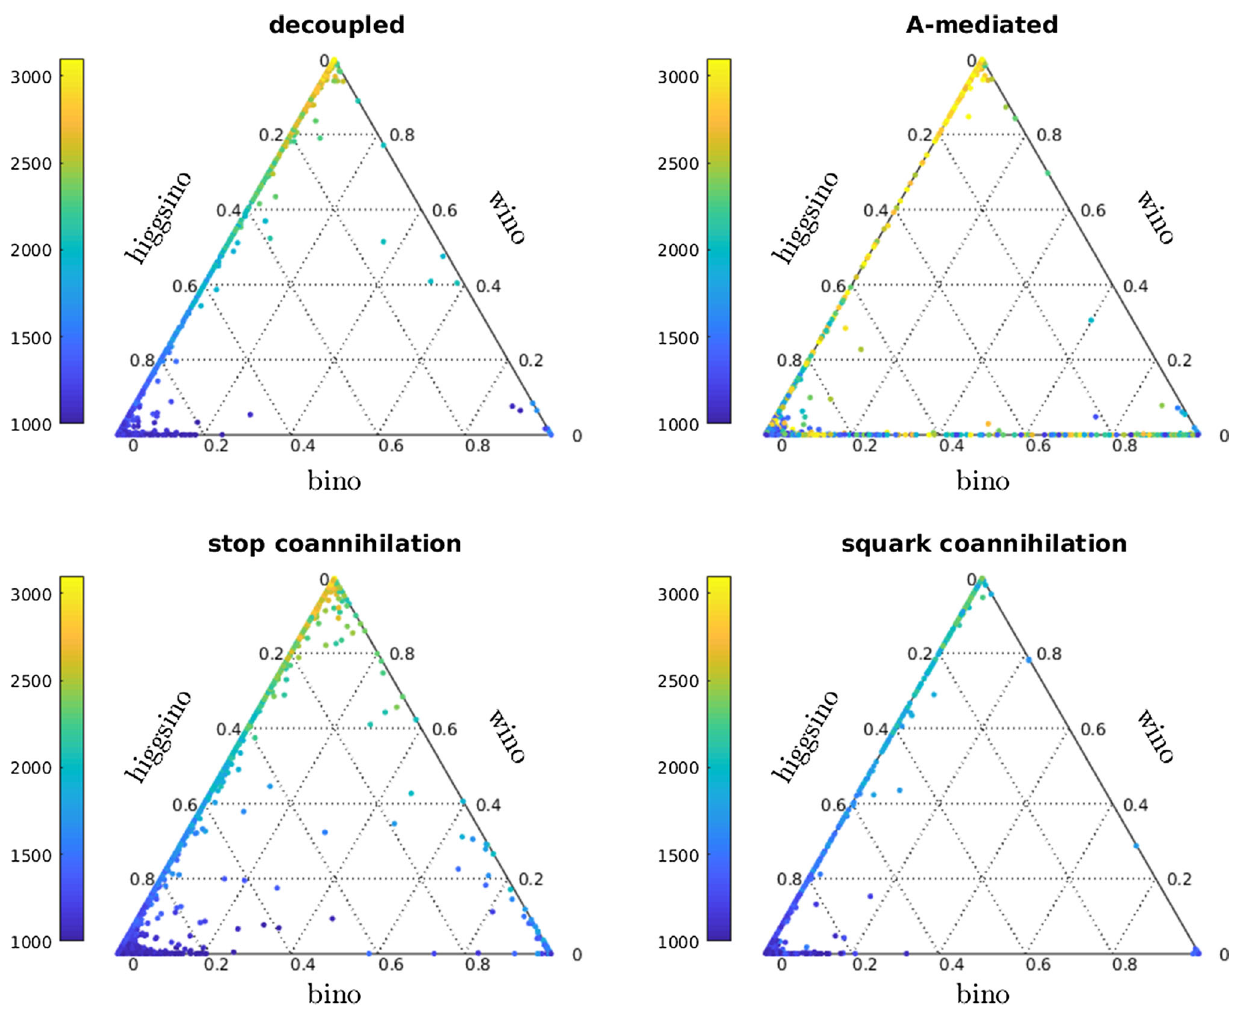
Fig. 1 Scatter plots of the TeV neutralino dark matter showing the components under the requirement of thermal relic density. The colors denote the dark matter mass from 1 to 3.1